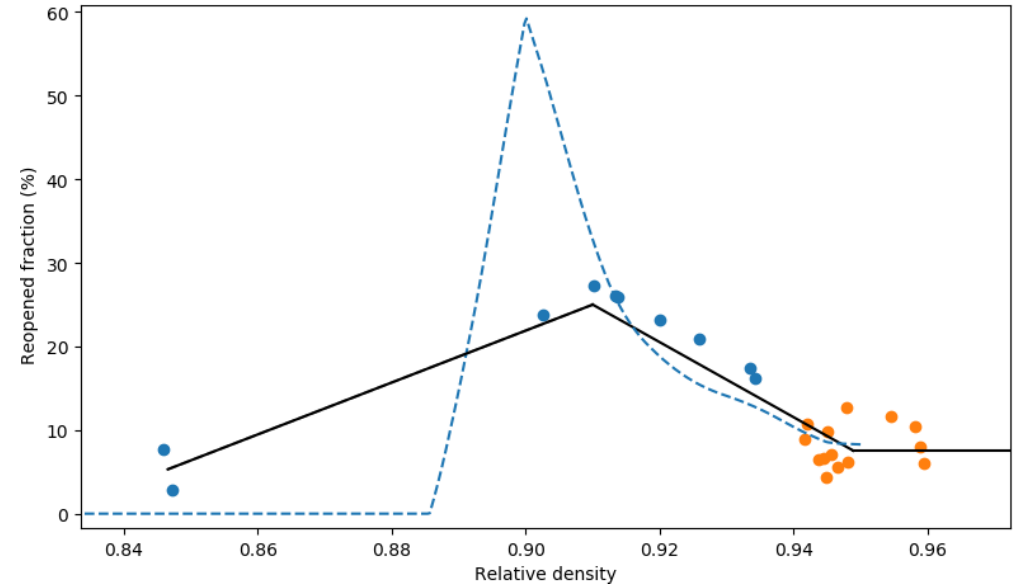
Figure 3. Fraction of reopened bubbles as a function of relative density. Values obtained from tomography samples are represented as blue dots, and values obtained from pycnometry measurements are represented as orange dots. The piecewise linear model used to correct for cut-bubble effect is displayed as a solid black line. The correction necessary to reproduce the closed porosities observed by Schaller et al. (2017) is displayed as a dashed blue